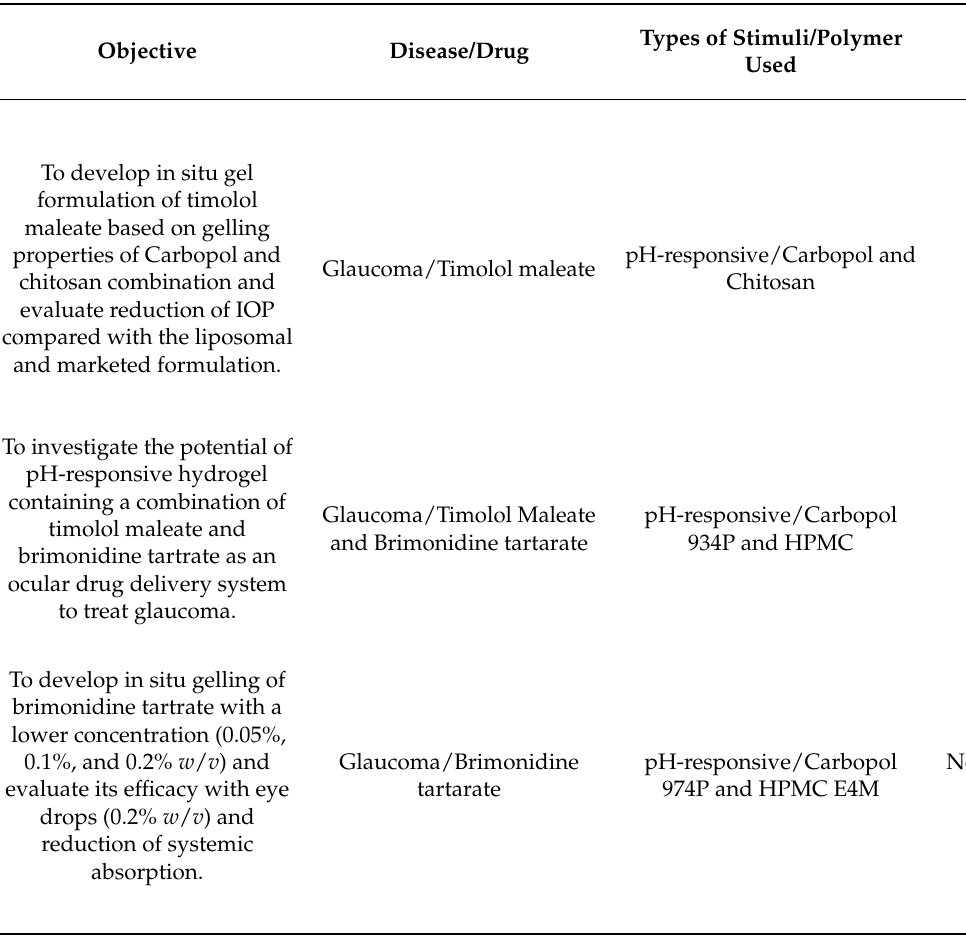
Table 2. Smart ocular delivery using pH-responsive in situ gel approach against ocular